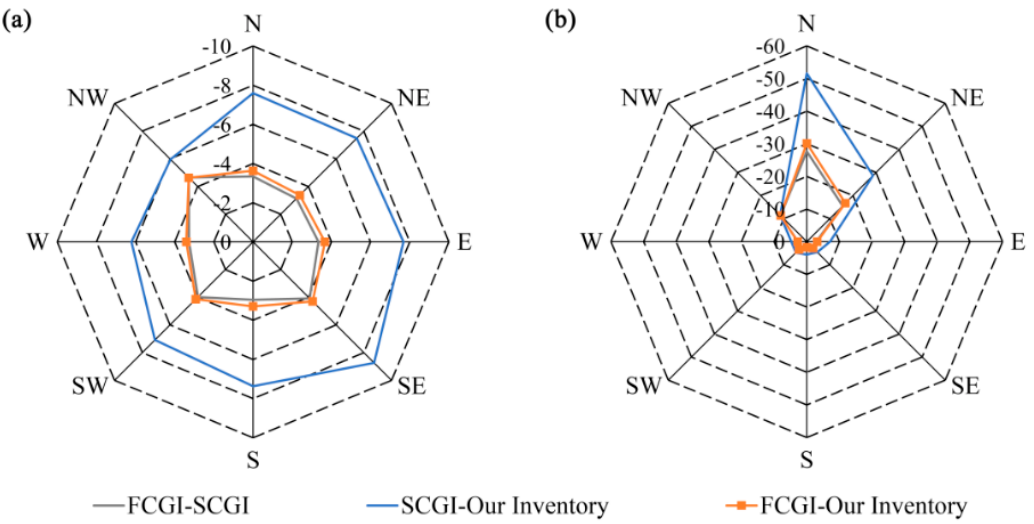
Figure 8. Orientation characteristics of glacier area changes in the Qilian Mountains: ( a ) glacier area decrease (%/10a), and ( b ) area changes (km 2 /10a).